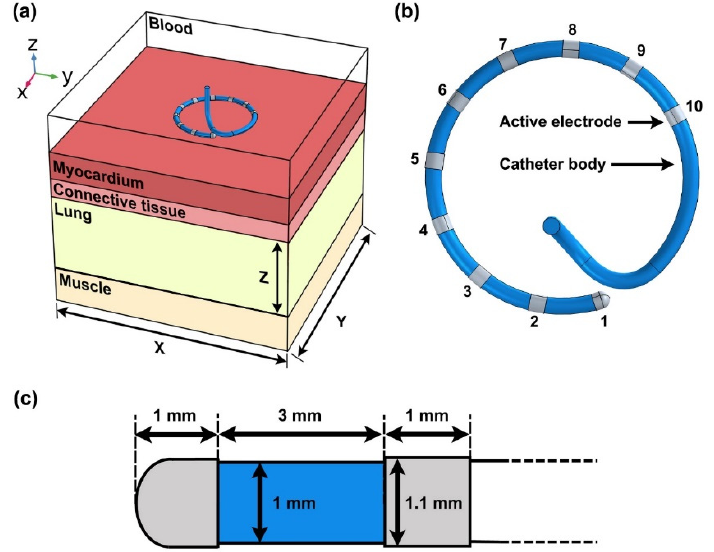
Figure 1. Geometry of ( a ) the ablation model, ( b ) the circumferential multipolar catheter (CMC) model from top view, and ( c ) detailed dimensions of electrode and catheter body (not to scale). The thicknesses of blood, myocardium, connective tissue, and lung and muscle were fixed to 9, 5, 2, and 18 mm, respectively, and the dimensions of X, Y, and Z (X = Y) were obtained by employing a convergence test. The catheter was inserted into the myocardium to a depth of 0.1 mm. The active electrode had a diameter of 1.1 mm and a length of 1 mm. The tip of the first electrode was round. The electrodes were placed 3 mm apart. For convenience, the electrodes were numbered 1 to 10.